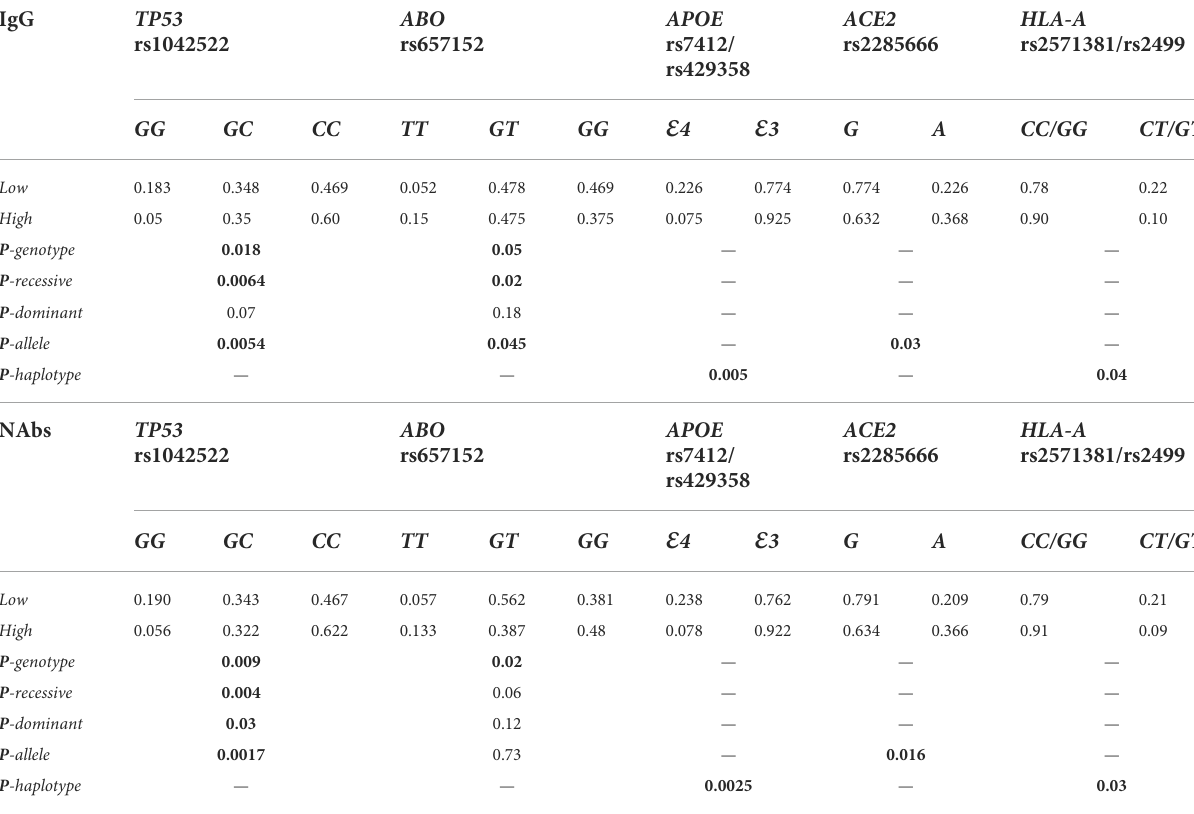
TABLE 5 Genotype, allele or haplotype frequency of the selected gene variants in the area below and above the trend lines of the IgG and NAbs distribution in the whole